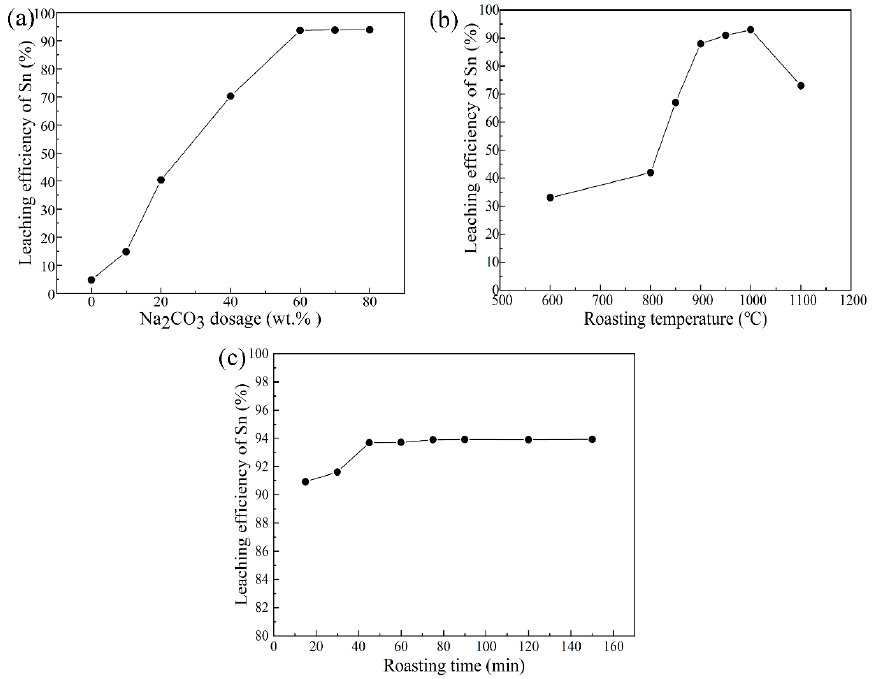
Figure 3. Effect of roasting parameters on leaching efficiency of tin: ( a ) Na 2 CO 3 dosage (1000 °C, 45 min); ( b ) temperature (60% of Na 2 CO 3 , 45 min); ( c ) time (60% of Na 2 CO 3 , 1000 °C).